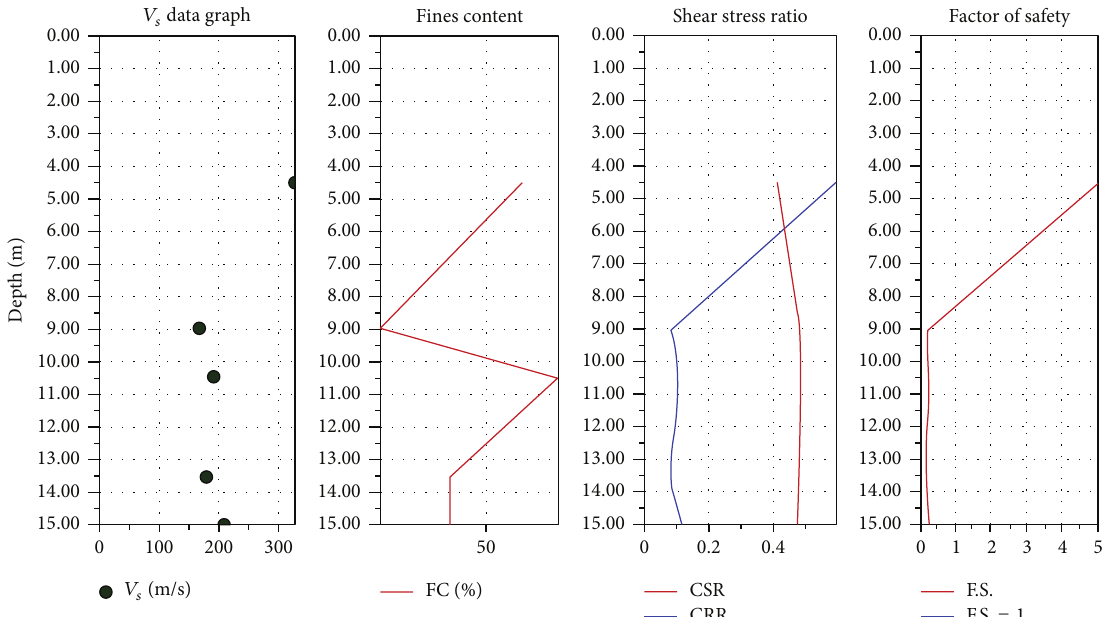
Figure 8: Borehole 23 was chosen to check and compare for liquefaction potential as a sample according to shear wave velocity values.